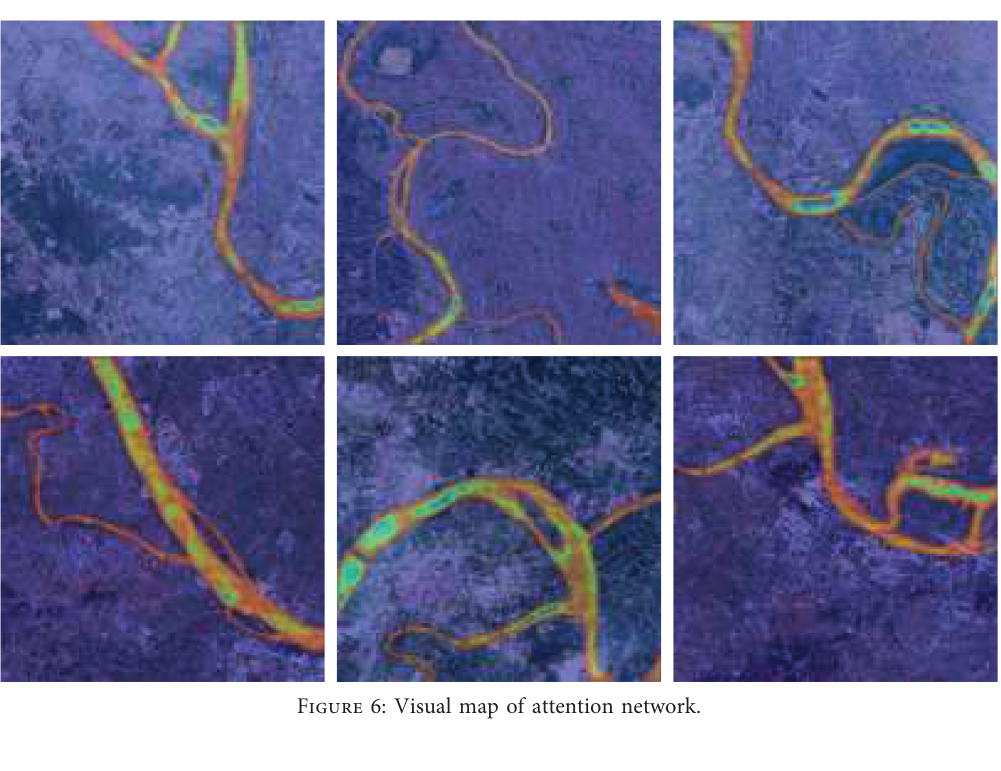
Figure 6: Visual map of attention network.